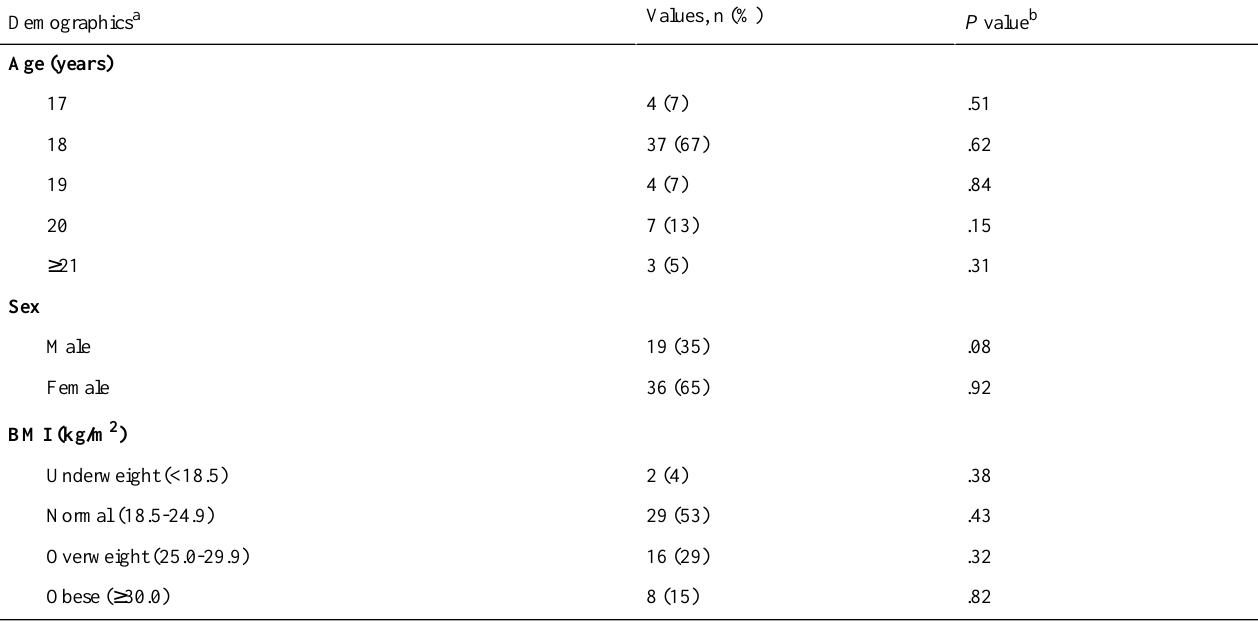
Table 2. Demographic characteristics of the intervention group (N=55).